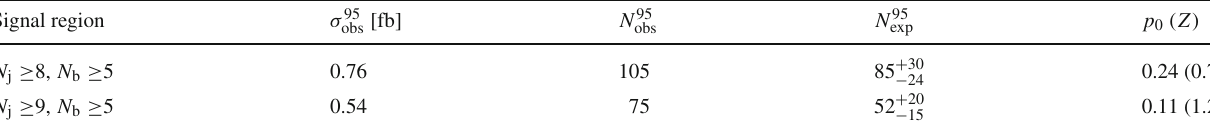
Table 6 Observed 95% CL model-independent upper limits on the vis- ( N j ≥ 9, N b ≥ 5). The p 0 value quantifies the probability that the background-only hypothesis would result in a fluctuation that gives an ible BSM cross-section, σ 95 , expressed in fb, along with the observed obs event yield equal to or larger than the one observed in the data, and Z (expected) limits, N 95 ( N 95 exp ), on the number of excess events. The obs is the corresponding Gaussian significance limits are determined for two signal regions, ( N j ≥ 8, N b ≥ 5) and Signal region σ 95 obs